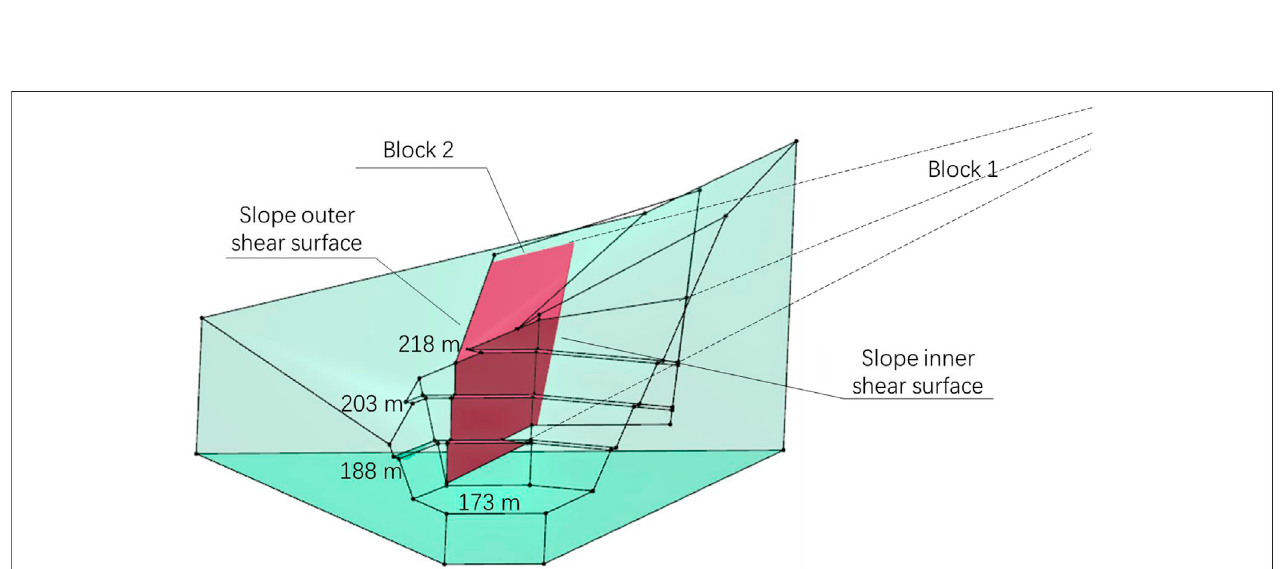
FIGURE 8 | Semilocating the block on the upstream slope of the dam abutment (blocks 1 and 2).